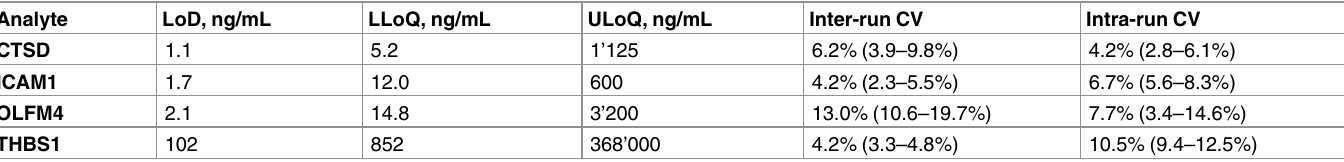
Table 1. Measuring range and